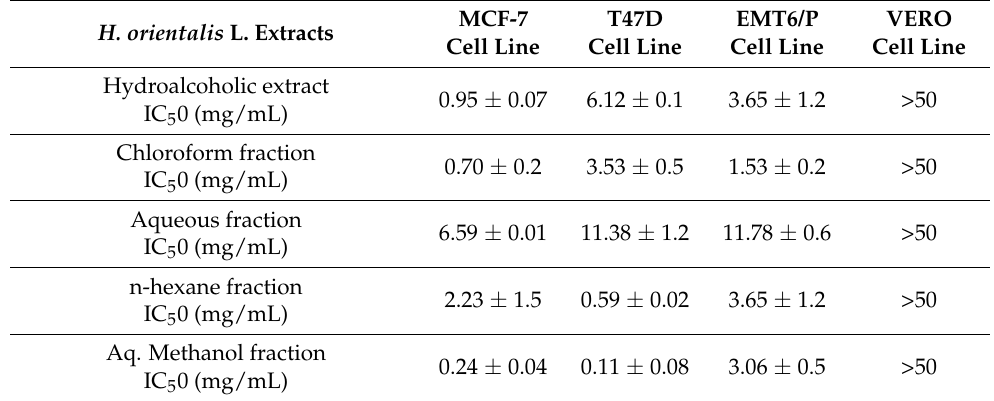
Table 2. IC 5 0 values of H. orientalis L. extract and fraction against different cell lines.